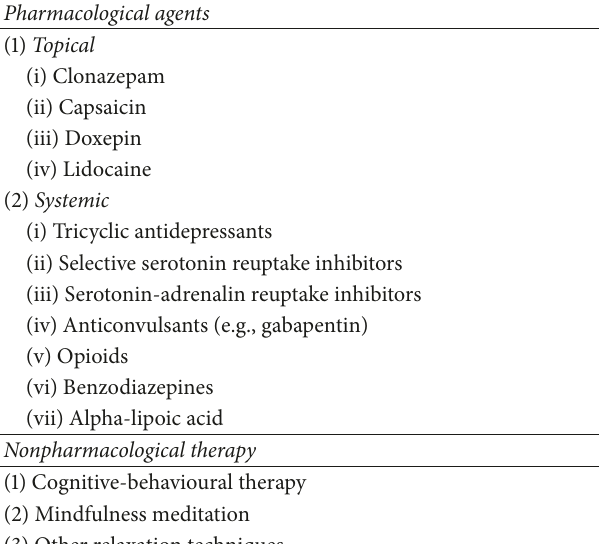
Figure 1: The interrelation between chronic pain, anxiety, depres- sion, and other emotions. The greater the intensity of the pain the greater the suffering, and anxiety, depression, and the stressful emotions may aggravate the experience of pain. Table 2: Available agents or strategies for the management of BMS based on expert opinion and common clinical practice. Adapted from